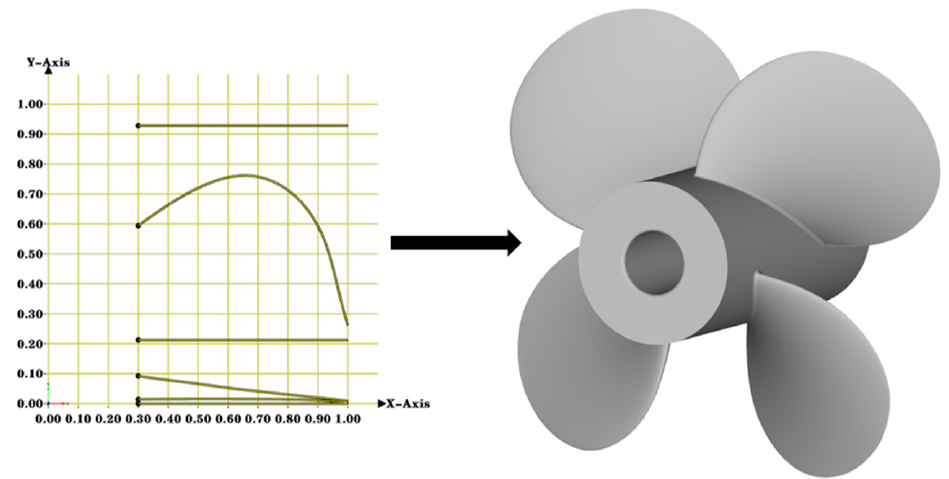
Figure 2. Propeller fully parametric model.